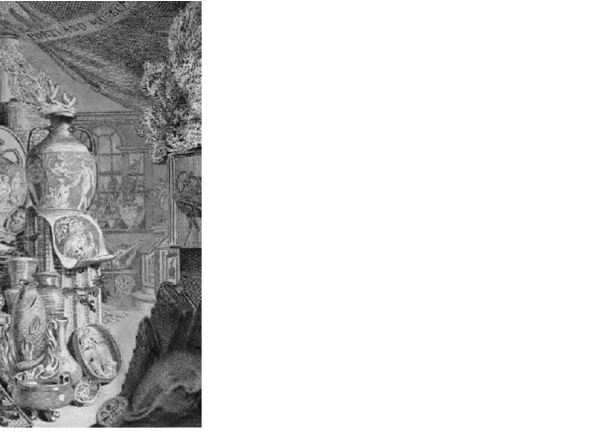
Figure 3. Frontispiece to A Catalogue of the Portland Museum, London, 1786